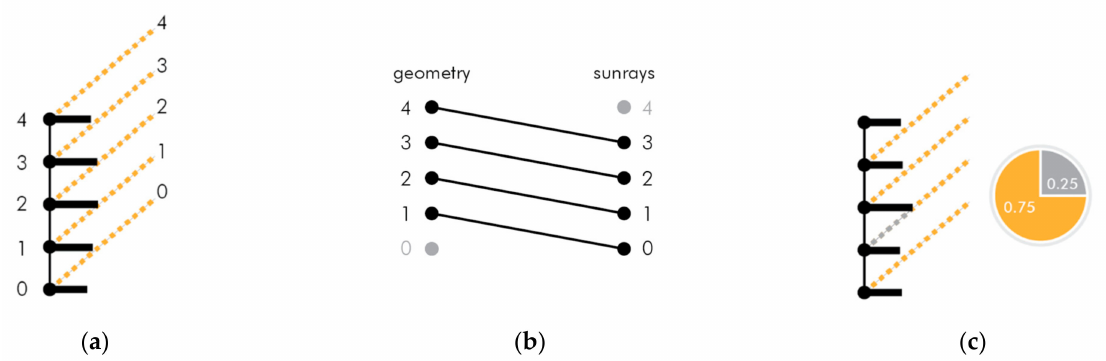
Figure 8. ( a ) Sun rays projected from the surface towards the sun. ( b ) Matching shading elements with sun rays a row below for intersection check. ( c ) Performance measure as the ratio of blocked or passing sunrays.